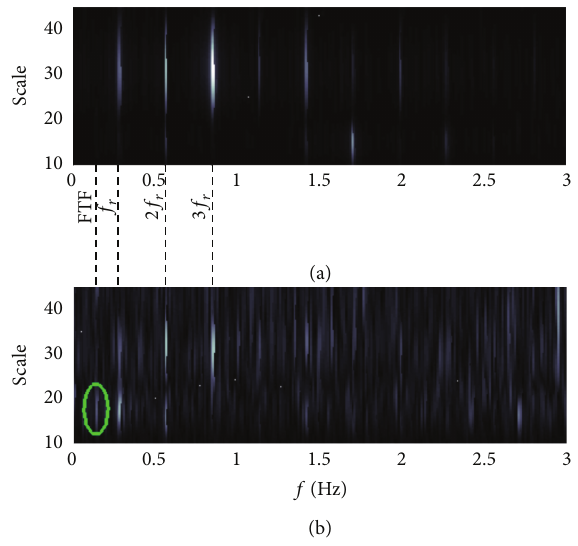
Figure 13: Multiscale enveloping spectrogram in chn08 and chf08. (a) Normal and (b)